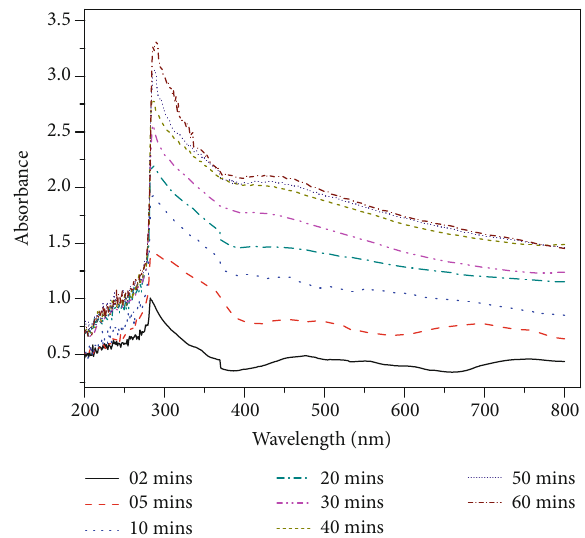
Figure 3: UV-VIS spectral study of the polymer and its recycled composites.